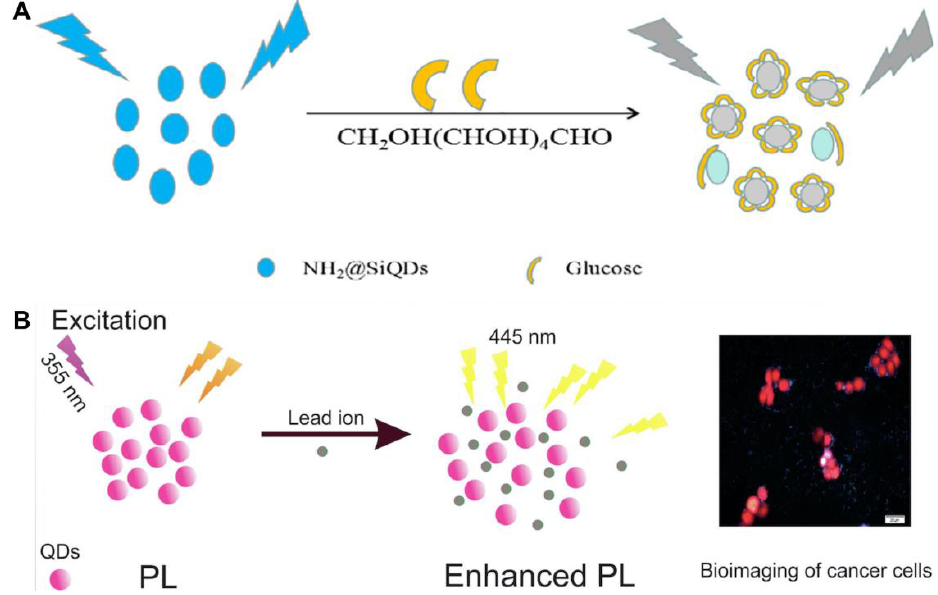
Figure 4. ( A ) Schematic illustration of the free-enzyme biosensor for sensitive glucose detection. Reproduced from [67], with permission from Elsevier, 2019. ( B ) Schematic illustration of the nanosensor developed for lead detection. Reproduced from [46], with permission from Elsevier, 2021.